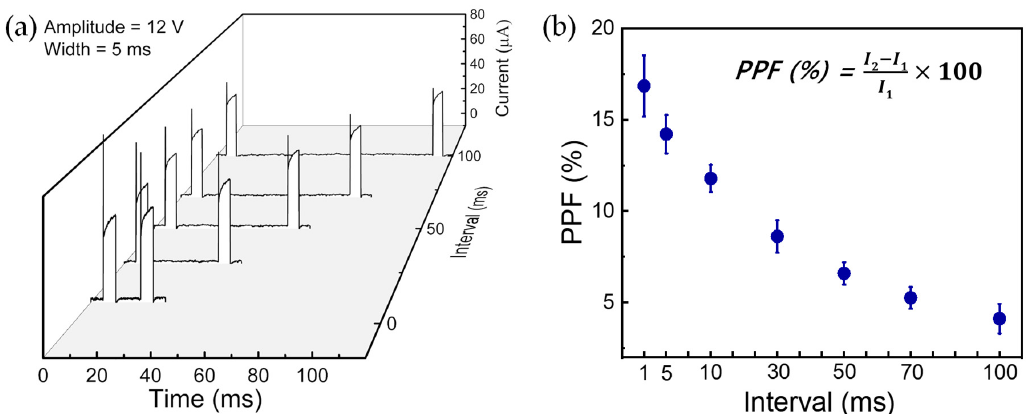
Figure 4. PPF characteristics of the Pt/HfO 2 /TaO x /TiN device. ( a ) I–V characteristics with different interval times. ( b ) Statistical distribution of PPF as a function of interval time.